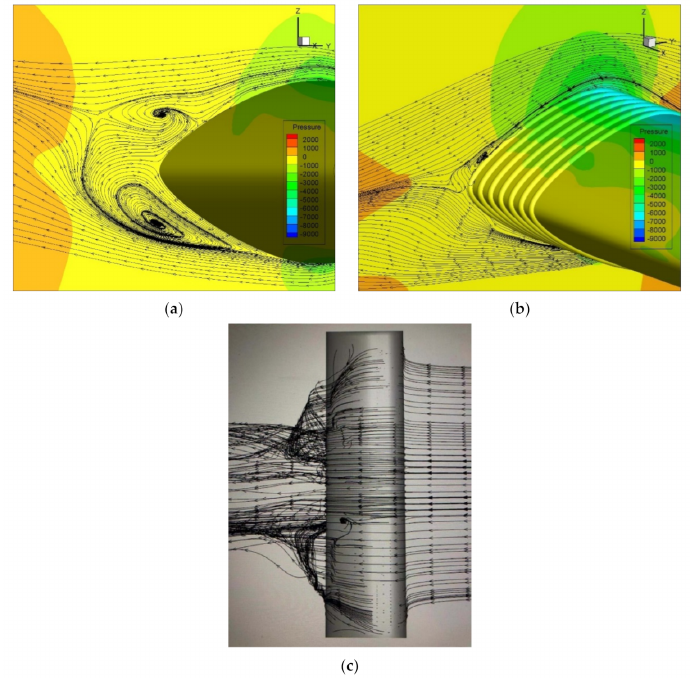
Figure 7. The pattern of the airflow around the blade: ( a ) without rings; ( b ) with rings; ( c ) global view of the